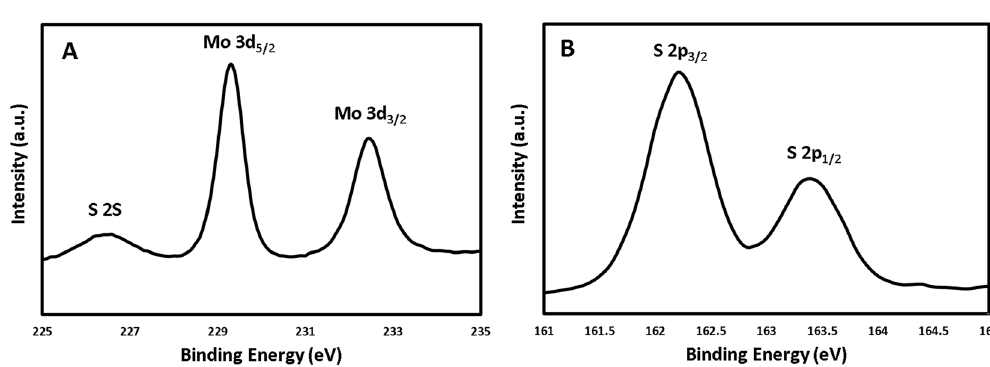
Figure 7. ( A ) XPS data corresponding to the Mo binding energy. ( B ) XPS data corresponding to the S binding